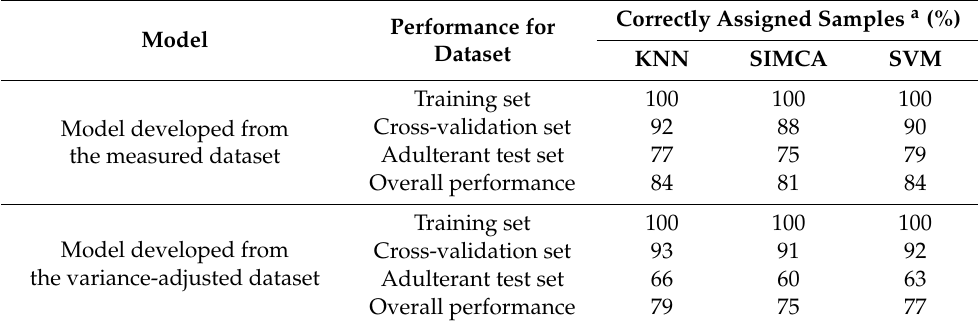
Table 2. The results of the one-class classification models developed from the measured dataset and variance-adjusted dataset. All the present values refer to the average of 100 repetitions of cross- validation for the corresponding